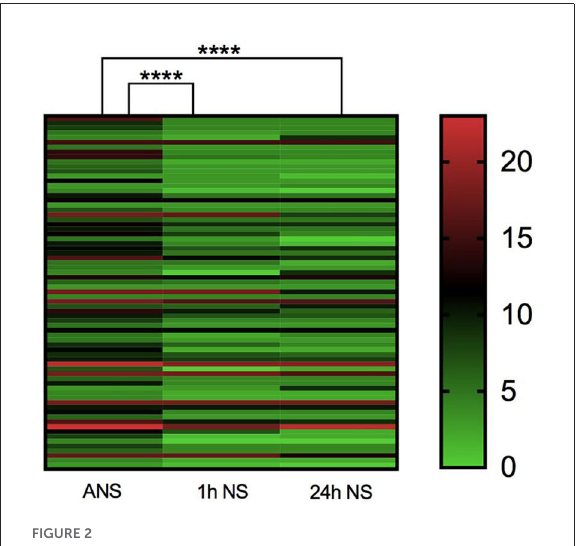
FIGURE2 Heatmap of admission NIHSS score, 1h NIHSS score of thrombolysis, and 24h NIHSS score of thrombolysis. **** p <